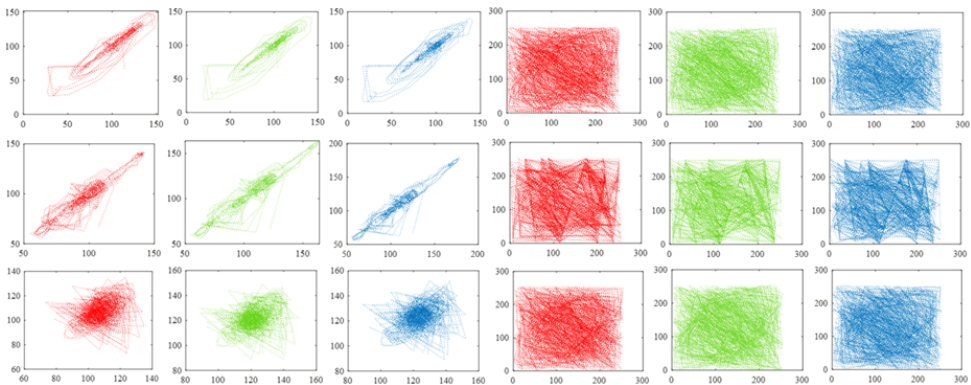
Figure 9. Correlation values of adjacent pixels of image car. The first, second, and third columns are drawn based on adjacent pixels from the red, green, and blue channels of the original image, and the fourth, fifth, and sixth columns are drawn based on adjacent pixels of signal Y c . The three rows show the results calculated from horizontal, vertical, and diagonal directions, respectively. The compression rate is 0.7.